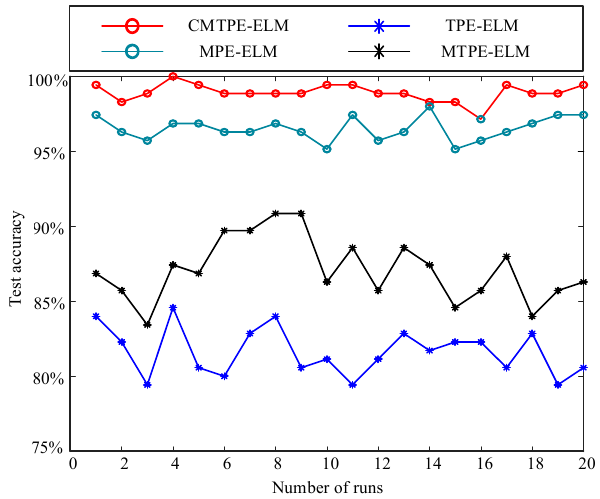
Figure 9. Test accuracy of the four strategies. Table 2. Average test accuracy and variance of the four methods.